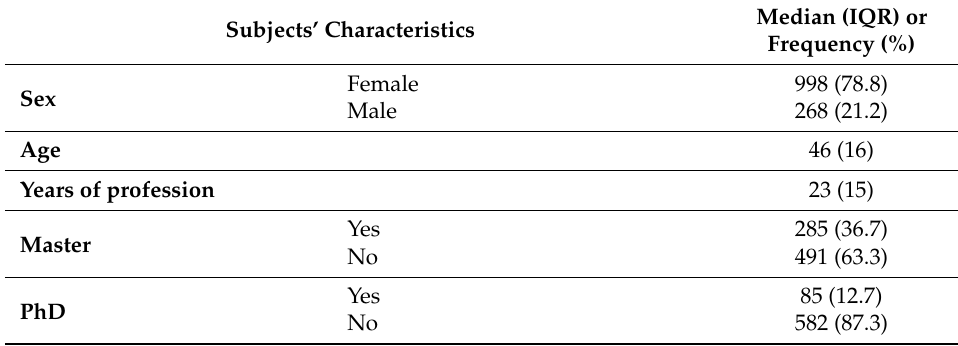
Table 1. Descriptive variables of the sample.